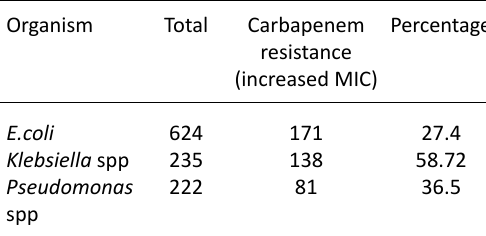
Table 3. Carbapenem resistance based on MIC